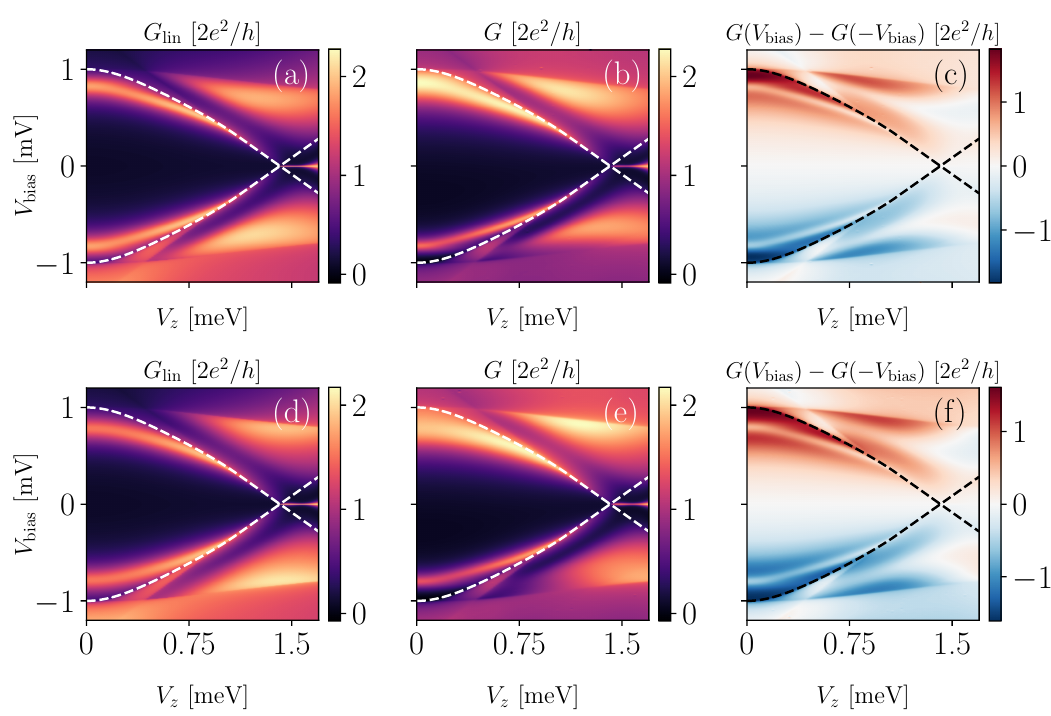
Figure 5: Two-terminal conductance as a function of Zeeman field and bias voltage in a proximitized nanowire with ∆ = 1 meV. The system in the top panels has a square = 0.8 meV), and in bottom panels a triangular barrier ( V barrier ( V barrier meV). (a) and (d) show the linear response conductance, (b) and (e) the finite-bias conductance and (c) and (d) the asymmetry in finite-bias conductance.